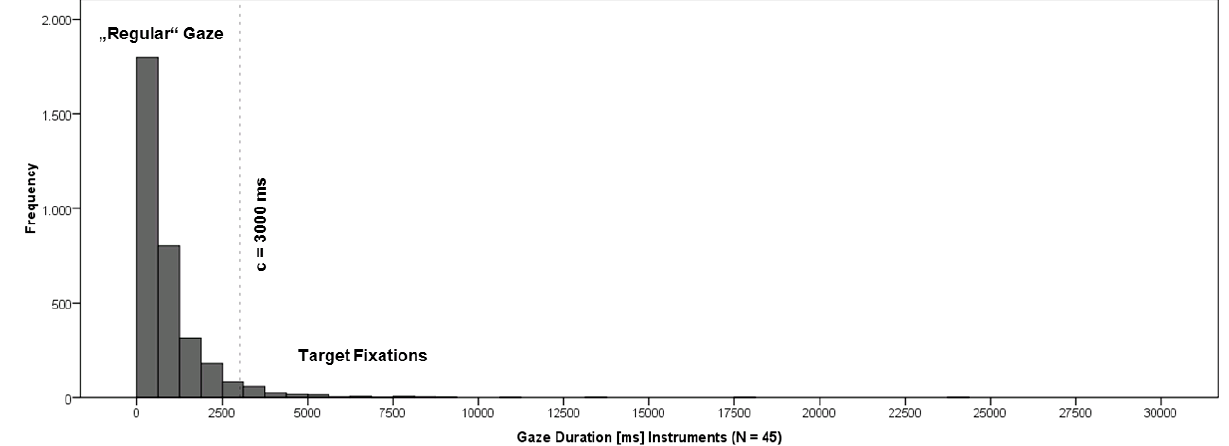
Figure 4. Frequency Distribution of Gaze Duration for OTW (c = M Gaze Duration + 3* SD Gaze Duration; see Inhoff & Radach, 1998).